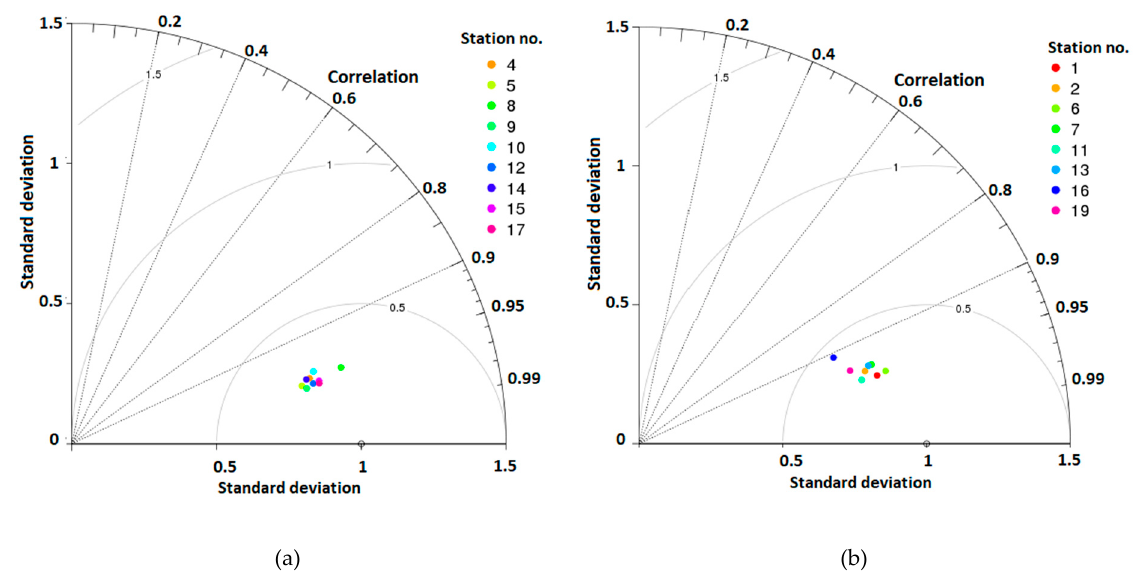
Figure 8. Taylor diagram for forecast air temperature for ( a ) mountain and hill peaks and ( b ) valley bottoms for the period 1 January to 30 April 2018.